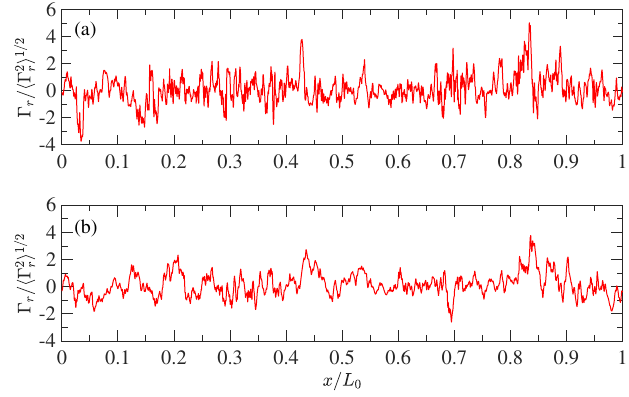
FIG. 1. Typical circulation traces in the inertial range, for ¼ 1300 (computational domain 8192 3 ) along an arbitrary R λ edge of the cube of length L 0 . The linear sizes r of the loops are (a) r= η ¼ 50 and (b) r= η ¼ 150 , corresponding, respectively, to the lower end and middle of the 4 = 5 plateau in the normalized third-order structure function [24].